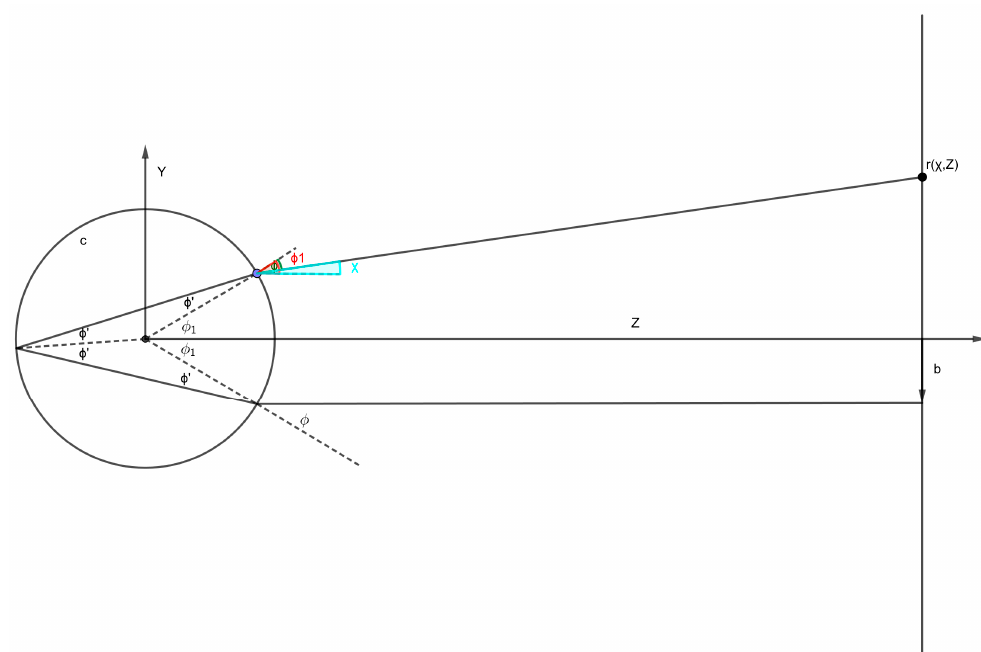
Figure 3. Scheme with the most important geometrical parameters for simple ray tracing. Sensors 2019 , 19 , x FOR PEER REVIEW Table 1. Fundamental equations for tracing rays of light impacting on a sphere (taken from [5]). Relation between ray (coming from the right side of the sphere) impact parameter b and impact angle φ (with R = radius of the sphere): Deflection angle of the ray exiting the sphere (Figure 4): χ = 4sin (cid:2879)(cid:2869) Position r of the point (on a hypothetical screen at distance z from the sphere bigger than its radius) mapping the input ray: Maximum deflection angle corresponding to the impact angle φ m (when z ≫ R ):